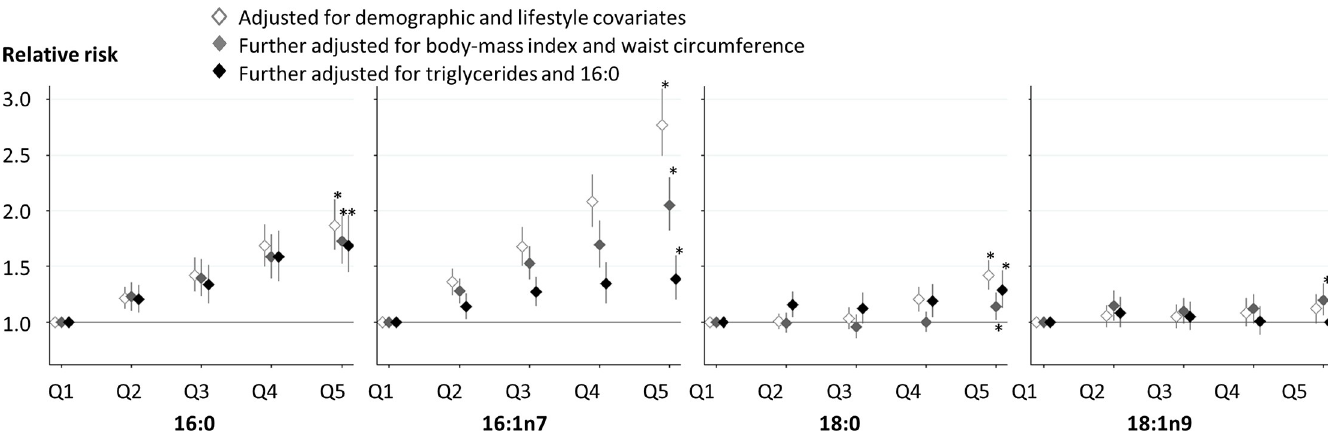
Fig 3. Associations of fatty acids in the DNL pathway with the incidence of T2D. Cohort-specific measures of associations across the quintile groups were pooled with inverse-variance-weighted meta-analysis. In each cohort, 3 different models were fitted: the first, adjusting for study field (if available), sex, age, smoking status, alcohol consumption, socioeconomic status, physical activity, dyslipidaemia, hypertension, and menopausal status (only for women); the second, adjusting for BMI and waist circumference; and the third, adjusting for triglycerides and 16:0 (for 16:1n7, 18:0 and 18:1n9) as the main products of DNL. A trend across quintiles of each fatty acid was tested with meta-analysis of cohort-specific regression coefficients of an ordinal variable of each fatty acid. The association with an asterisk showed p < 0.001 except for the second results for 18:0 ( p = 0.0158) and for 18:1n9 ( p = 0.0162). BMI, body mass index; DNL, de novo lipogenesis; T2D, type 2 diabetes.